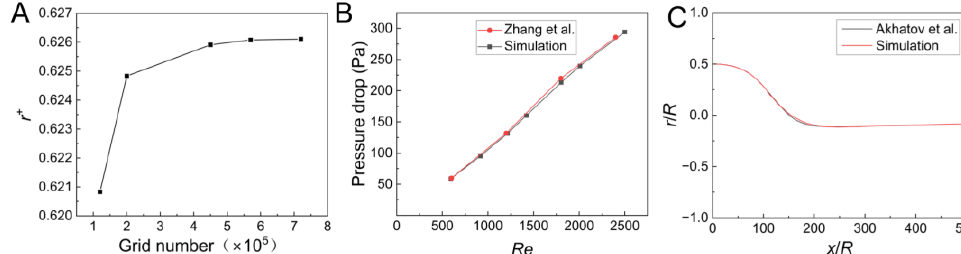
Figure 2. ( A ) Positions of the aerosol particle at outlet of the straight cylindrical microchannel under different grid numbers. ( B ) Pressure drop at various Re obtained by the literature [42] and by the present model. ( C ) Trajectories of the particle simulated by the literature [34] and the present model ( the radius of particle was 1 μm, the radius of the cylindrical microchannel was 50 μm, the initial particle position r 0 /R = 0.5, ρ p = 2000 kg/m 3 , ρ = 1.16 kg/m 3 , u max = 100 m/s).